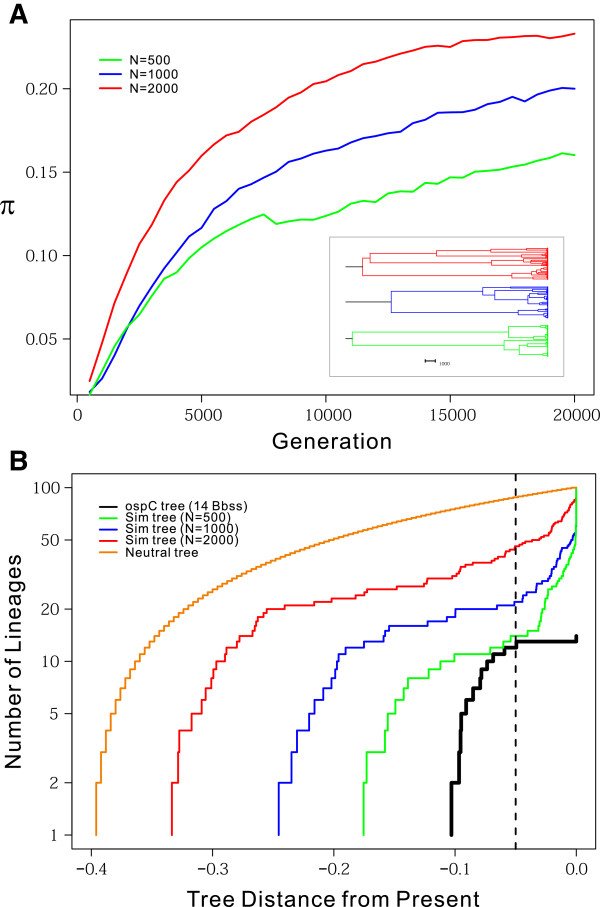
Predicted increase of genomic diversity with B. burgdorferi population expansion. We simulated evolution of three bacterial populations, each of which consisted of a constant size of N=500 (in green), 1000 (in blue), or 2000 (in red) haploid genomes. One of the eight genes in the simulated genome evolves under immune-mediated negative frequency-dependent selection (FDS) as ospC is likely to be. Other genes were under purifying selection like housekeeping genes. (A) We measured nucleotide diversity at the FDS locus by sampling 100 individuals every 500 generations. Doubling of the population size results in a proportional increase in nucleotide diversity. (Inset) We reconstructed the coalescence trees for the last population samples. These trees show characteristics of balancing selection such as elongated internal branches and compressed terminal branches. (B) Lineage-Through-Time (LTT) plots of the tree based on ospC sequences from 14 B. burgdorferi s.s. genomes (in black), a simulated neutral coalescence tree (in orange), and trees of FDS sequences from simulated populations (in green, blue, and red). In comparison with the neutrally evolving genomes, the LTT plots of balanced gene trees show early rapid rise of gene lineages that are subsequently maintained for a long period of time, before the final rapid rise to the sample sizes.